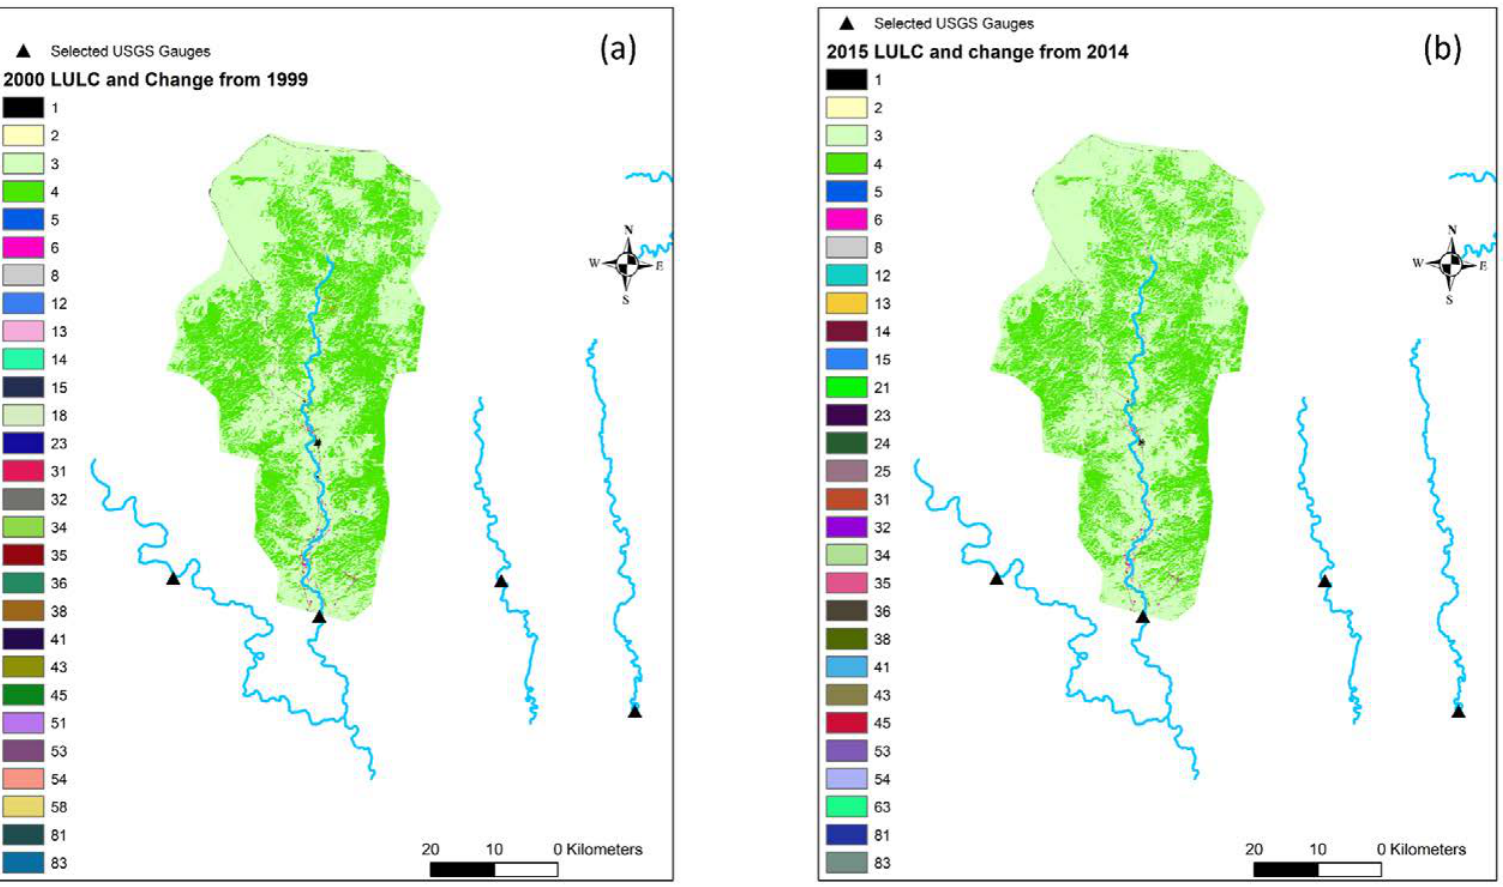
Figure S1. Figure S1. Land use land cover (LULC) for the watershed contributing to site 08190000: (a) in the year 2000 and change relative to 1999, (b) in the year 2015 and change relative to 2014. Site 08190000 is shown as a representative sample of the seven gages while years 2000 and 2015 are shown as representative samples of the LULC temporal dataset. LULC codes: 1 – developed land; 2 – cropland; 3 – grass/shrub cover; 4 – tree cover; 5 – water; 6 – wetland; 8 – barren; double digit codes show change from one category to another. For example, 12 indicates change from class 1 (developed) to 2 (cropland) during that 1-year time